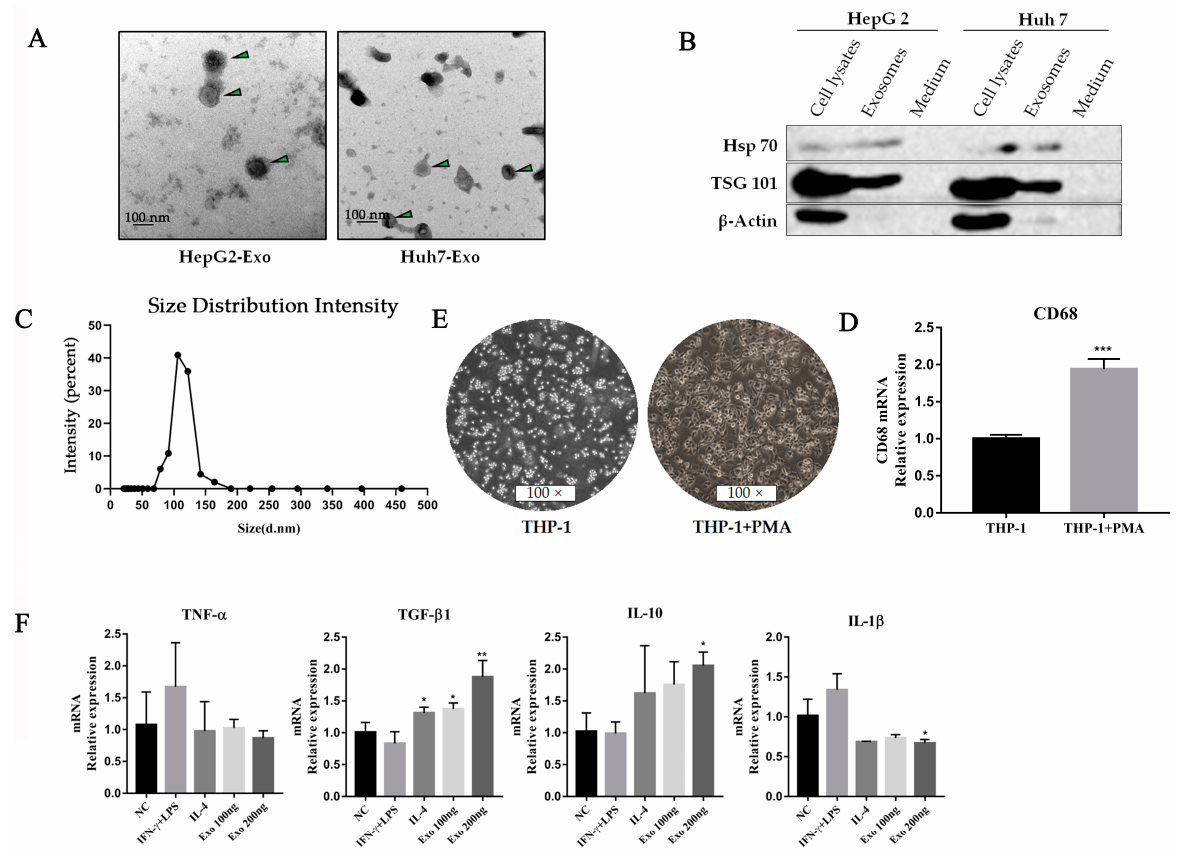
Figure 2. HCC-derived exosomes induced macrophage M2-like polarization. ( A ) Exosomes (HepG2 and Huh7) derived from HCC cell lines were collected by an ultrafiltration concentration and ultracentrifugation method. The morphology of exosomes was observed by transmission electron microscopy. The exosomes were marked with arrows. Scare bar: 100 nm. ( B ) Western blot analysis was used to detect exosome biomarkers (HepG2 and Huh7) derived from HCC cell lines, including Hsp70 and TSG101. ( C ) The sizes of HepG2 cell-derived exosomes were detected using a Mastersizer 3000. ( D ) Morphology characteristics of THP-1 cells after PMA treatment. THP-1 cells were seeded in 6-wells by 1 × 10 5 cells per well and treated with PMA for 48 h. ( E ) qPCR was used to detect CD68 levels in THP-1 cells after PMA treatment, *** p < 0.001. ( F ) Cytokines were detected by qPCR after HepG2-derived exosomes treated macrophages for 48 h. ** p < 0.01, * p <